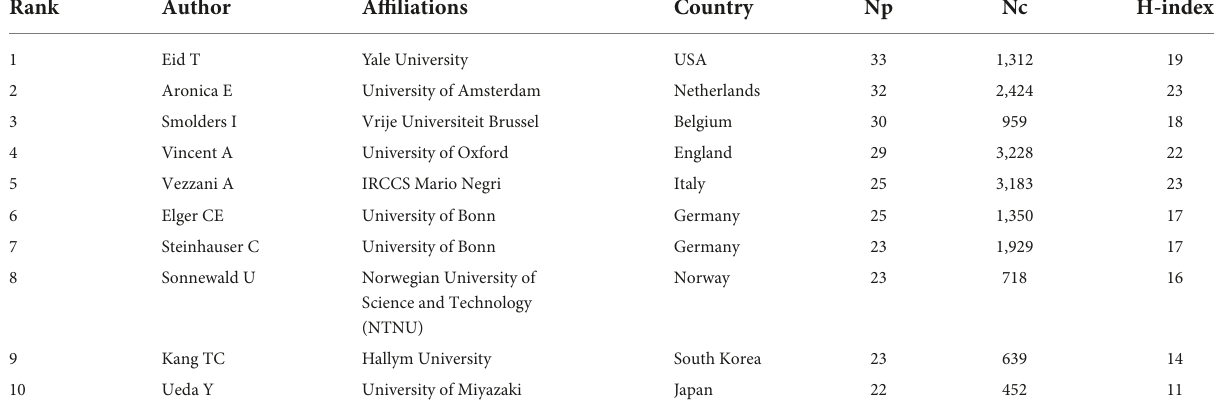
TABLE 4 Top 10 authors in terms of